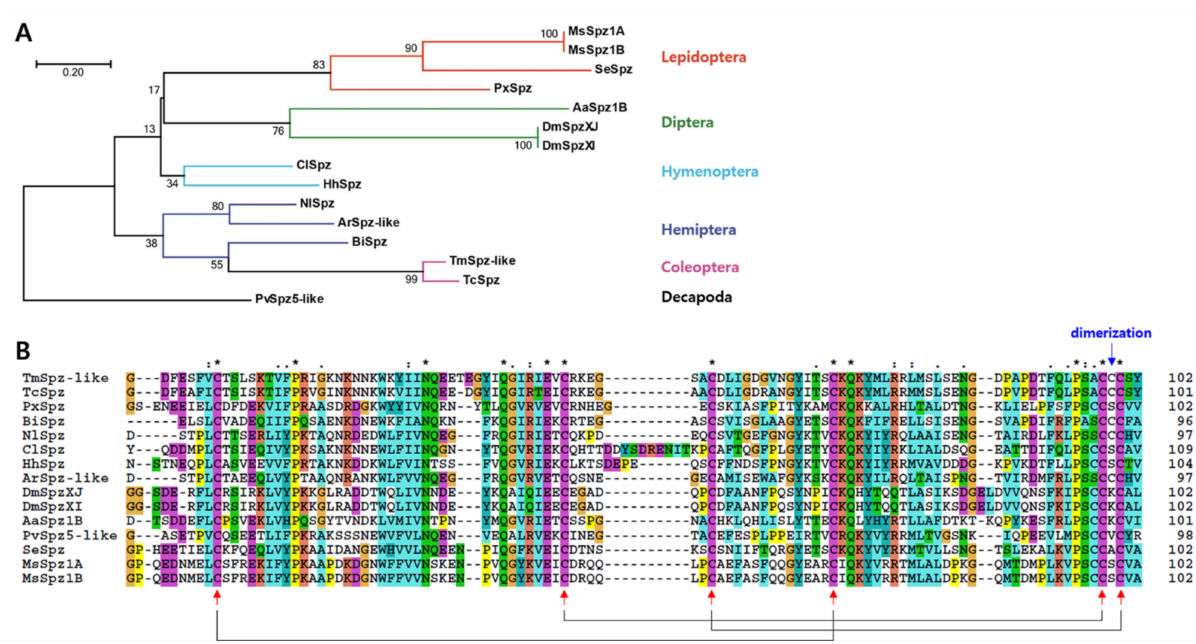
Figure 2. Molecular phylogenetic analysis of Tm Spz-like and its homologs in other insects. ( A ) Maximum likelihood-based phylogenetic tree based on the amino acid sequence of Tm Spz-like constructed using the MEGA 7.0 software. The numbers above the branches represent bootstrap values (1000 replications). ( B ) Multiple alignments of the deduced amino acid sequence of Tm Spz-like aligned using Clustal X 2.0.11. Identical and similar sites are identified with asterisks (*) and dots (: or .), respectively. Arrows represent the phylogenetically conserved cysteine residues forming the disulfide bridges featuring in the cysteine knot domain. The following protein sequences were used in the multiple sequence alignment and phylogenetic analysis: Tc Spz, Tribolium castaneum Spätzle (XP_008201191. 1); Se Spz, Spodoptera exigua Spätzle (KAF9408664. 1); Px Spz, Plutella xylostella Spätzle isoform X1 (XP_037962889. 1); Ms Spz1A, Manduca sexta Spätzle 1A (ACU68553.